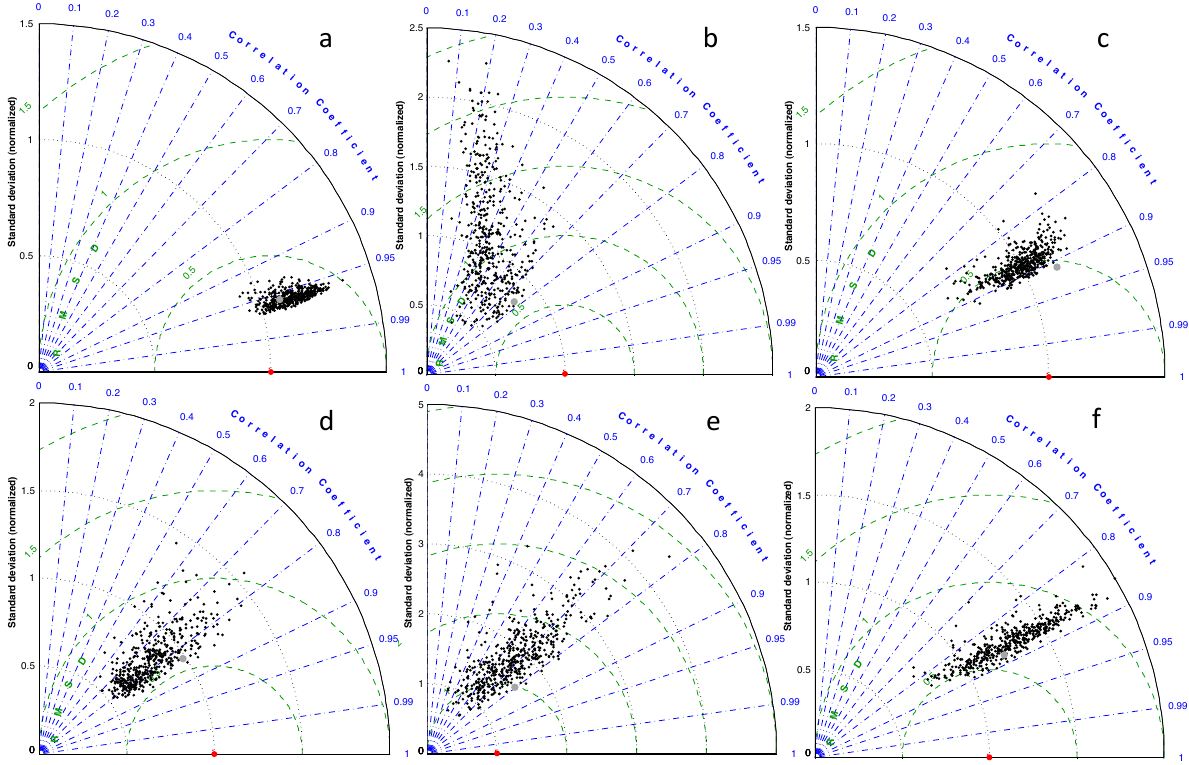
Fig. 2. Taylor diagrams for the EFPC ensemble (a) temperature, (b) salinity, (c) dissolved phosphate, (d) dissolved oxygen, (e) alkalinity and (f) dissolved inorganic carbon. Black circles are the 471 ensemble members. Large grey circles are the outputs of an optimised model configuration (Ridgwell and Death,